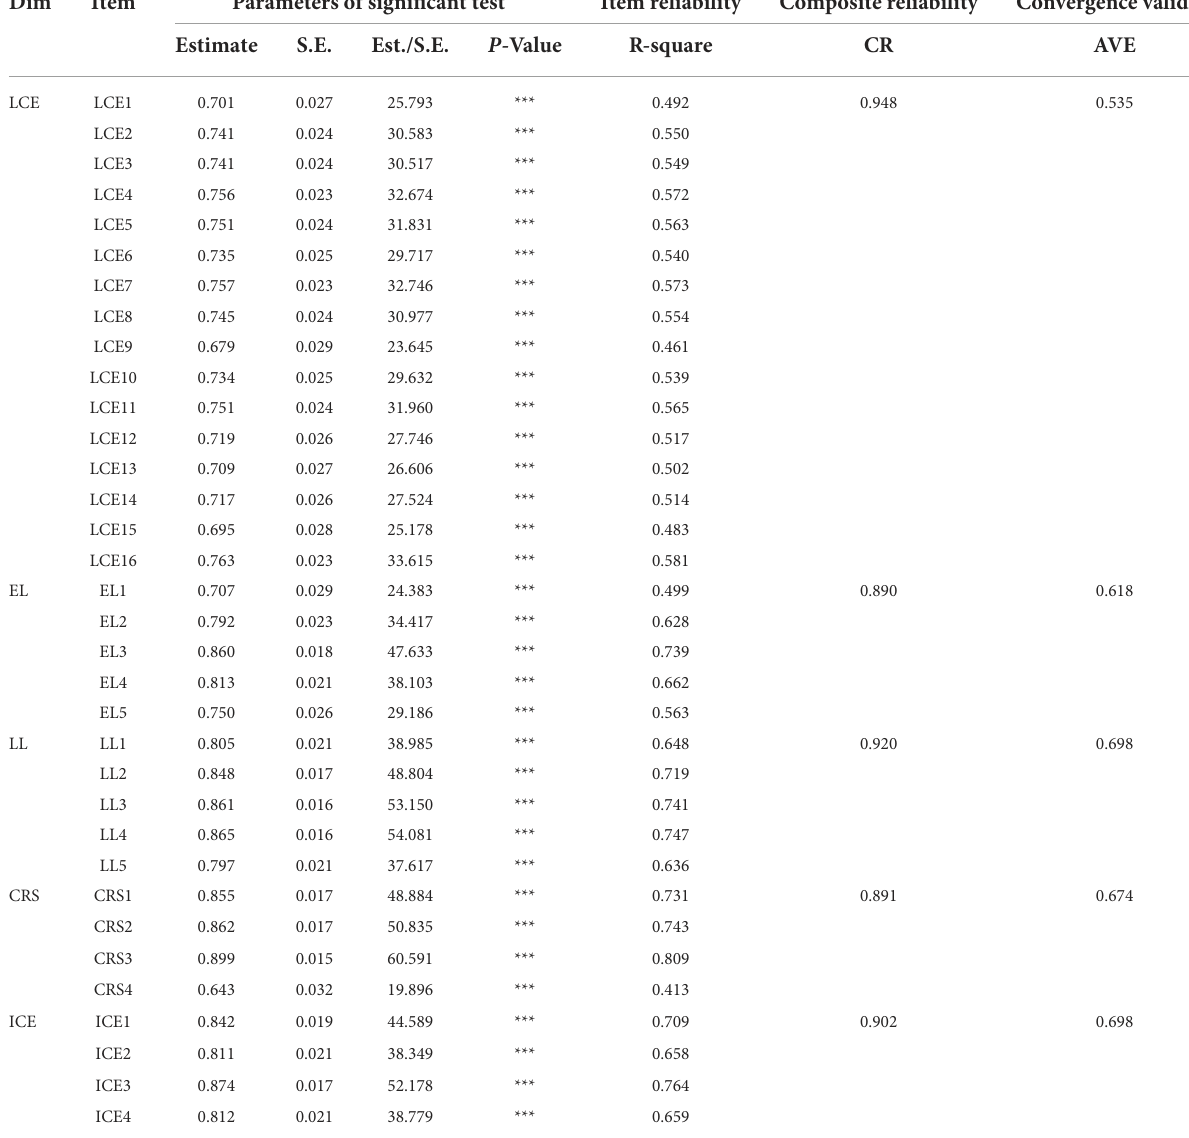
TABLE 1 Construct factor loading and